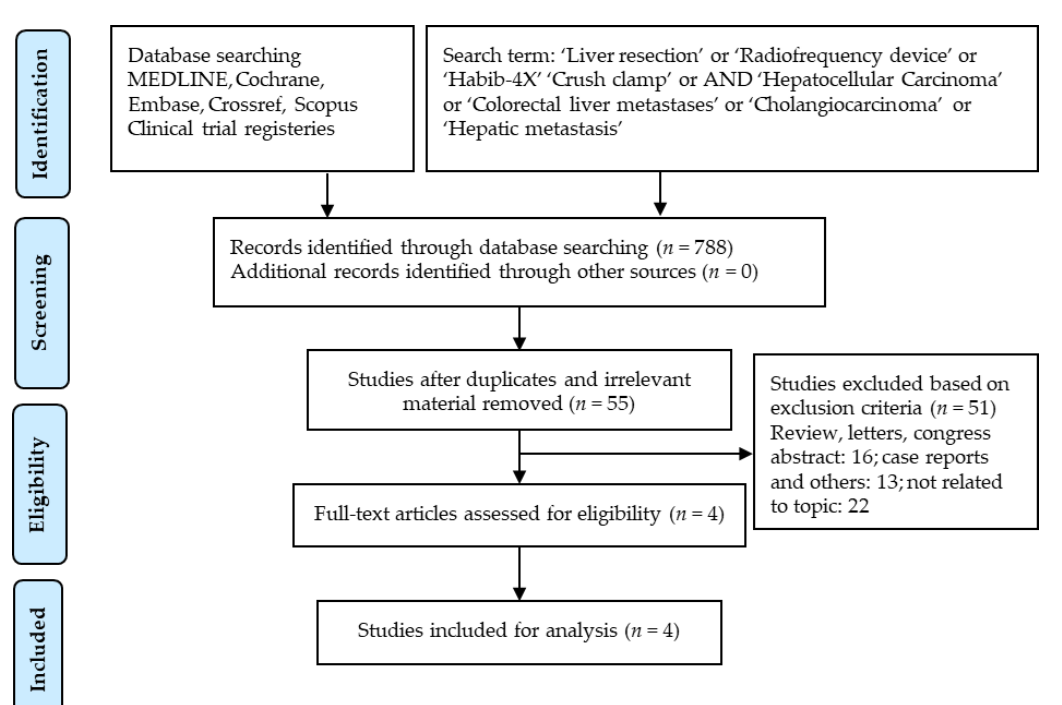
Figure 1. Search strategy and study selection used in this systematic review as per the PRISMA protocol.